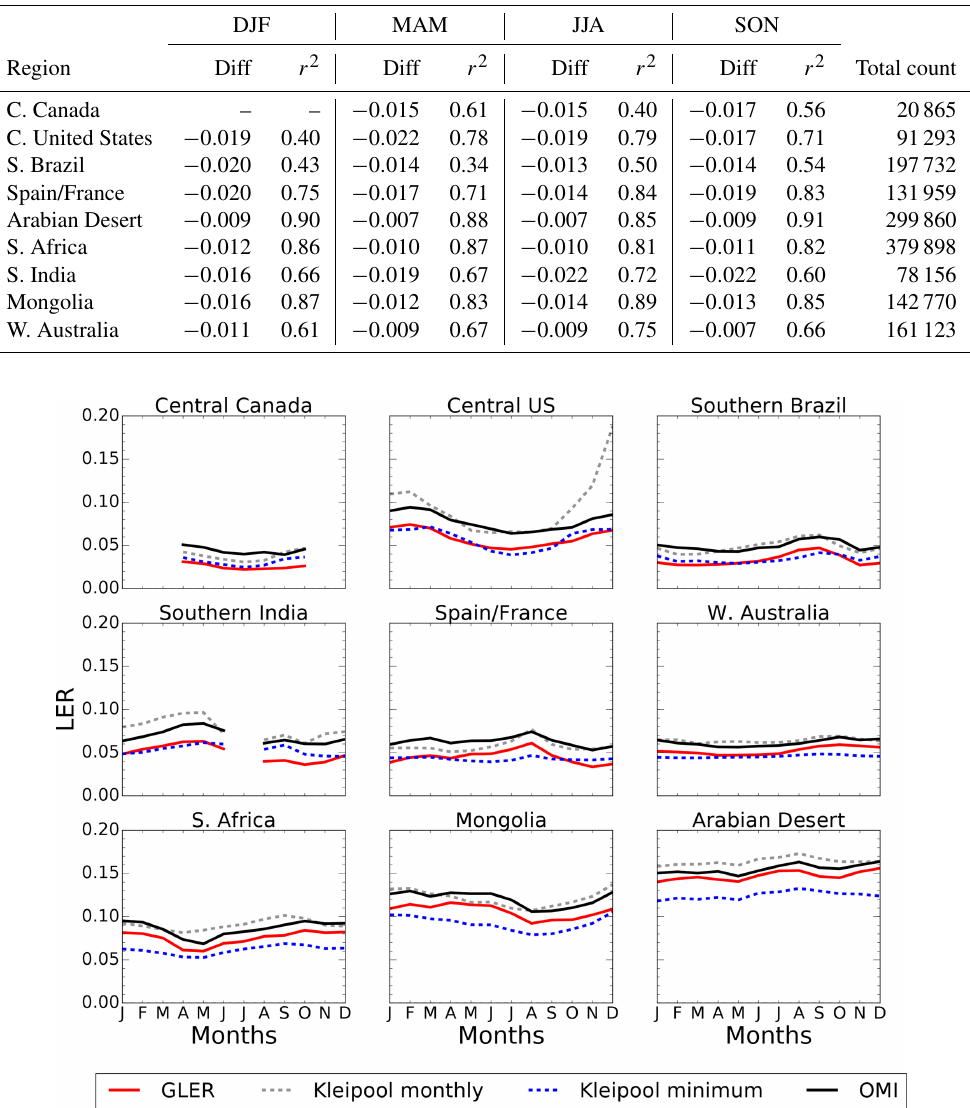
Figure 6. Seasonal dependence in 2006 of GLER (solid red), Kleipool et al. (2008) monthly climatological LER (dashed grey), Kleipool et al. (2008) minimum climatological LER (dashed blue), and OMI-derived LER (solid black) at